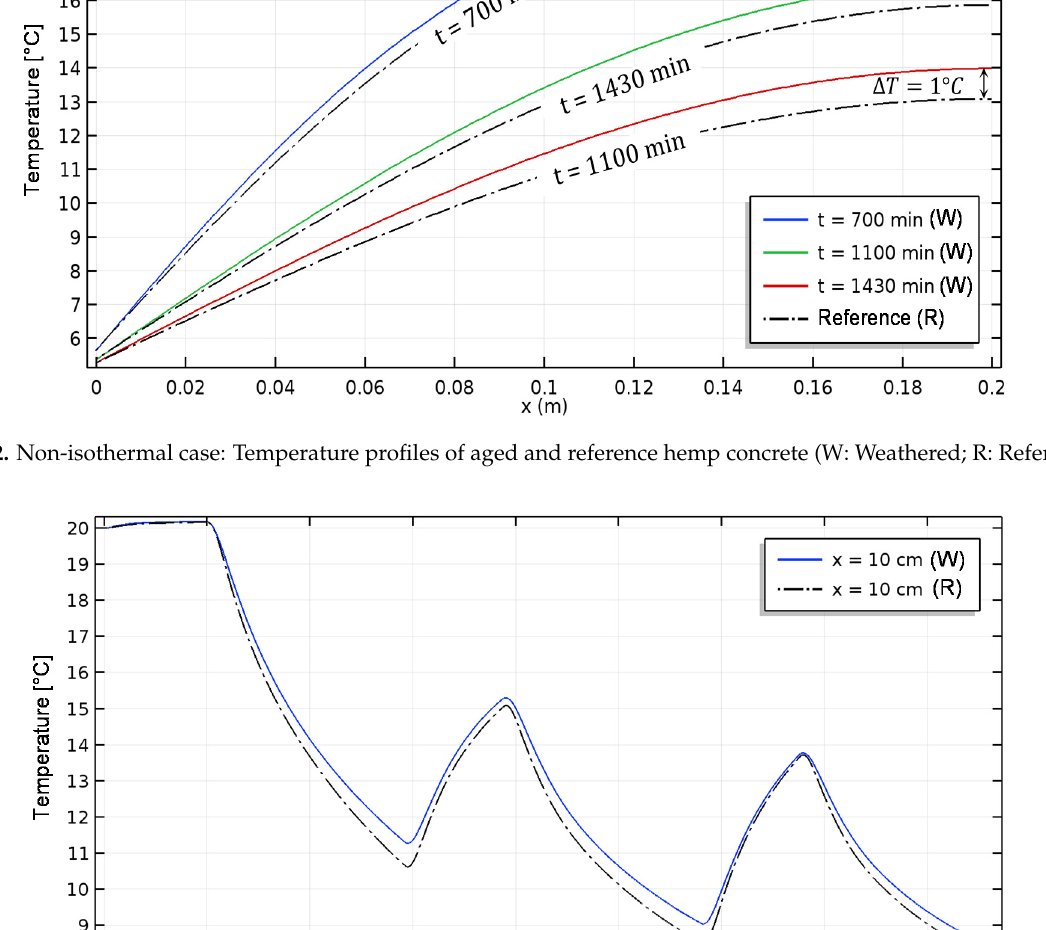
Figure 14. Non-isothermal case: Relative humidity profiles of aged and reference hemp concrete (W: Weathered; R: Ref- erence).